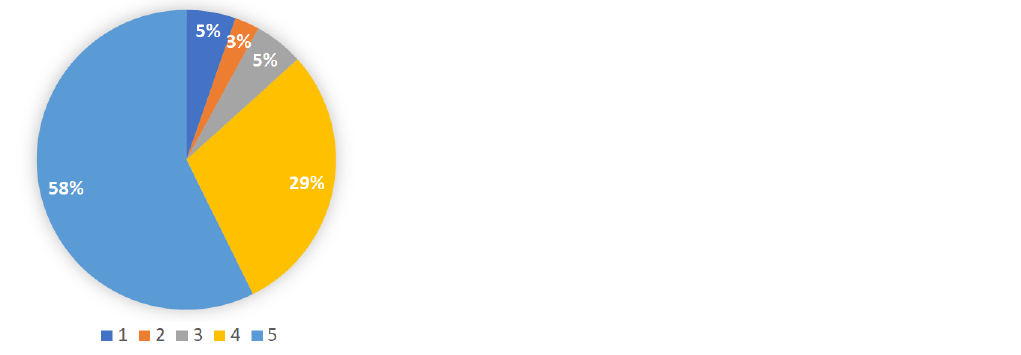
Figure 5. Student preferences over traditional learning using a book (1) or using an e-learning software